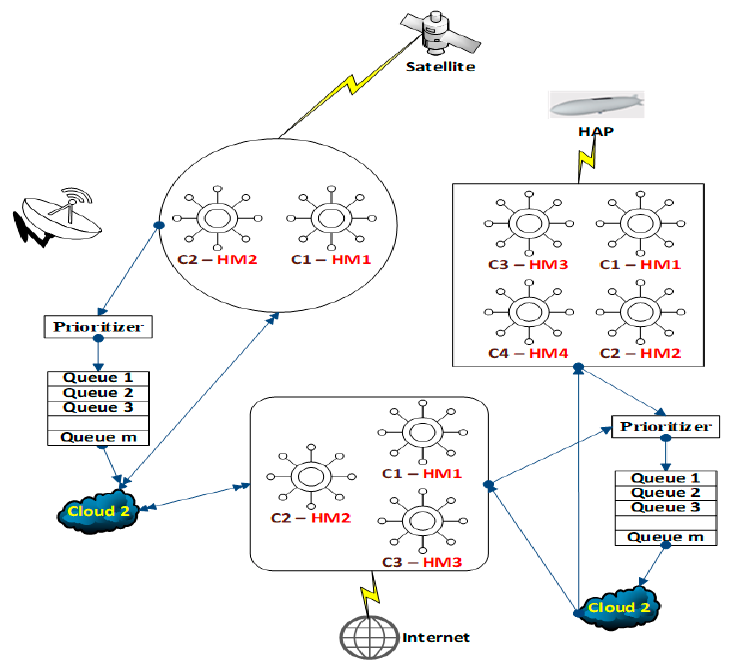
Figure 5. Simple view of the proposed healthcare architecture workflow.